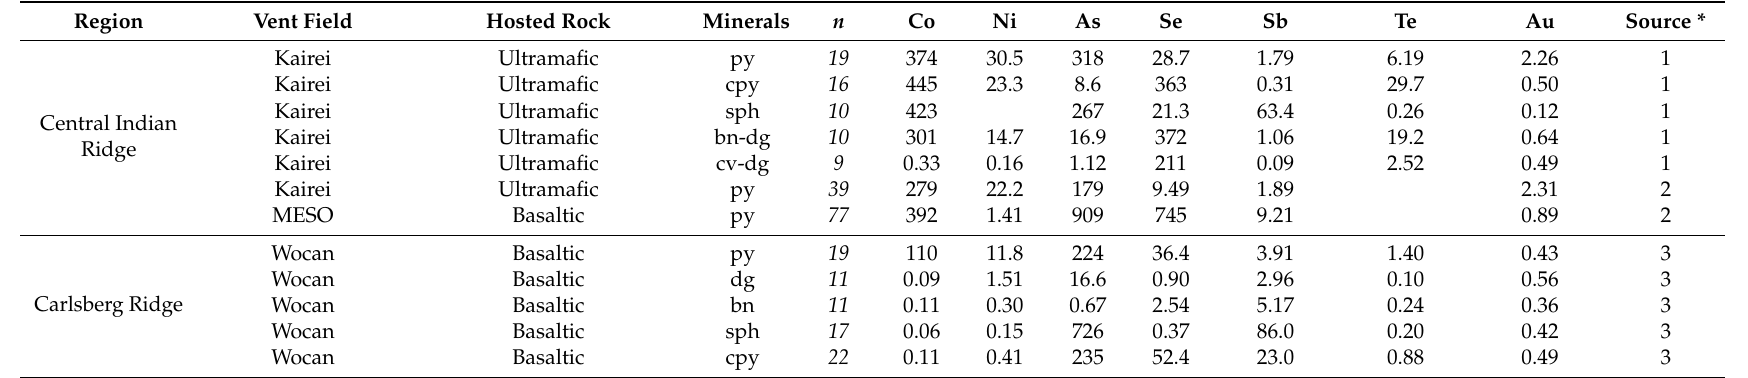
Table 3. Average contents (ppm) of selected trace elements in the sulfide minerals in the seafloor hydrothermal systems. Region Vent Field Hosted Rock